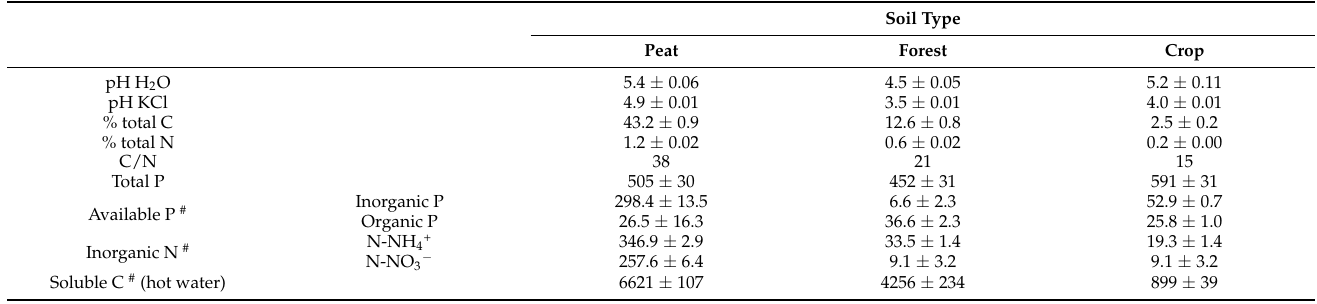
Table 1. General characteristics of the three soils used for the acclimation of willow plantlets. Values are presented as mean ± standard deviation.